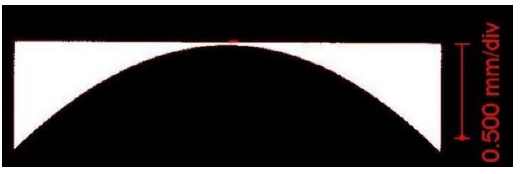
Fig. 2. Optical micrograph of the calculated mask .